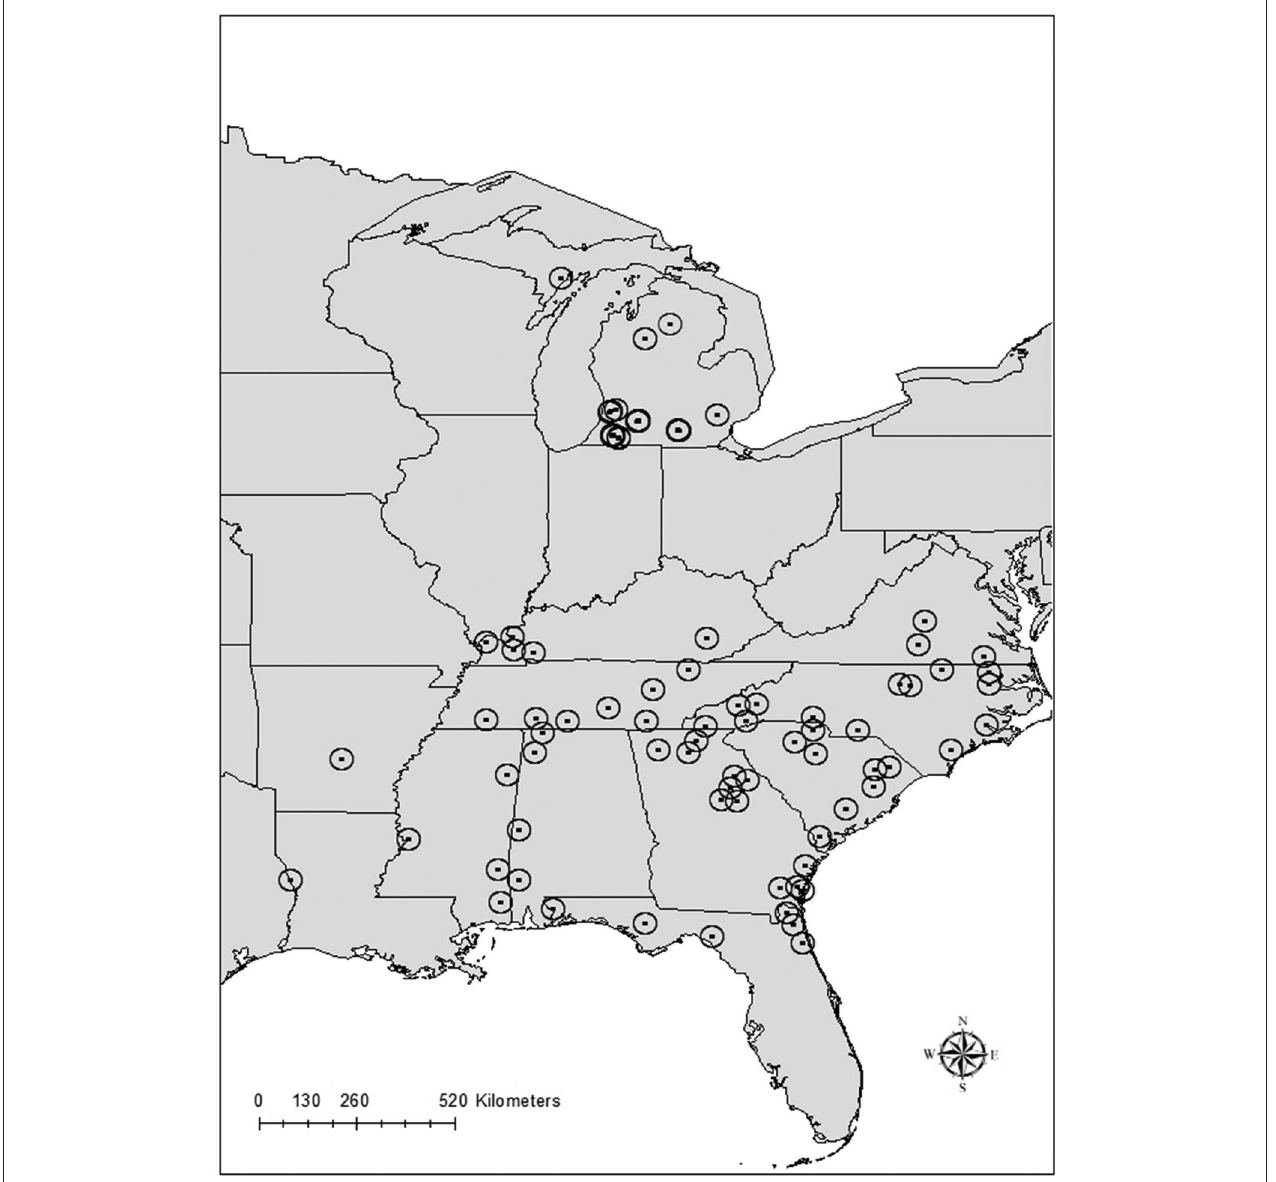
FIGURE 1 | Geographic locations in Eastern USA where tree data were collected for this